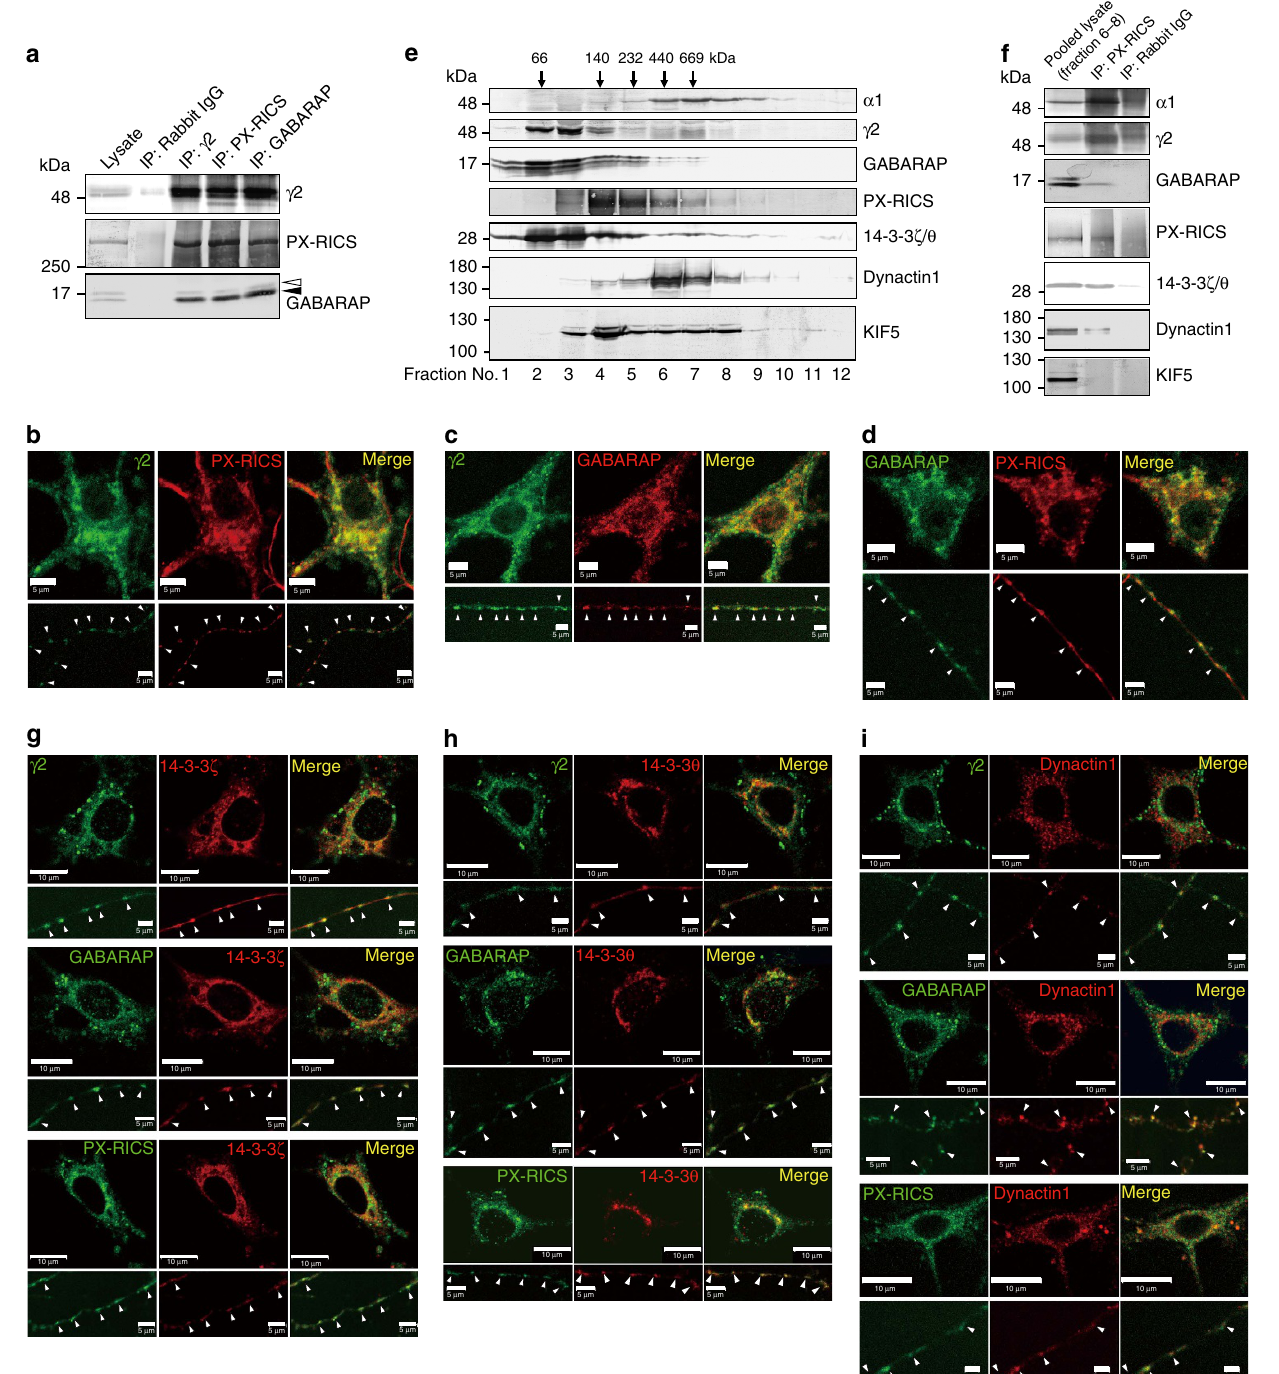
Figure 4 | PX-RICS is central to a large cargo-adaptor-motor complex in cortical neurons. ( a ) Co-immunoprecipitation analysis. Note that GABARAP (solid arrowhead) but not GABARAPL1 (open arrowhead) preferentially coprecipitates with g 2 and PX-RICS. ( b – d ) Colocalization of PX-RICS, GABARAP and g 2 in the perinuclear region of the soma and in specific compartments of the dendrites (white arrowheads). Scale bars, 5 m m. ( e ) Mouse cortical neurons solubilized with 1% digitonin were fractionated by linear sucrose density gradient (10–40%) ultracentrifugation, and each fraction was subjected to immunoblotting with the indicated antibodies. Arrows at the top indicate the mobilities of the molecular weight markers. ( f ) Fractions 6, 7 and 8 in e , the highest-molecular-weight fractions that contain all of the indicated proteins, were pooled and subjected to immunoprecipitation with anti-PX-RICS antibody, followed by immunoblotting with the indicated antibodies. Kinesin superfamily protein 5 (KIF5), a microtubule-dependent molecular motor, was used as a negative control for immunoprecipitation: it is present in fractions 6–8 ( e ), but does not coimmunoprecipitate with PX-RICS in the pooled lysate ( f ). KIF5 is known to interact with GABARAP to facilitate plus-end-directed retrograde transport of GABA A Rs (ref. 65). ( g – i ) g 2, GABARAP and PX-RICS were colocalized with 14-3-3 z ( g ), 14-3-3 y ( h ) and dynactin1 ( i ) in the perinuclear region of the soma and specific compartments of the dendrites (white arrowheads). Scale bars, 10 m m (soma); 5 m m